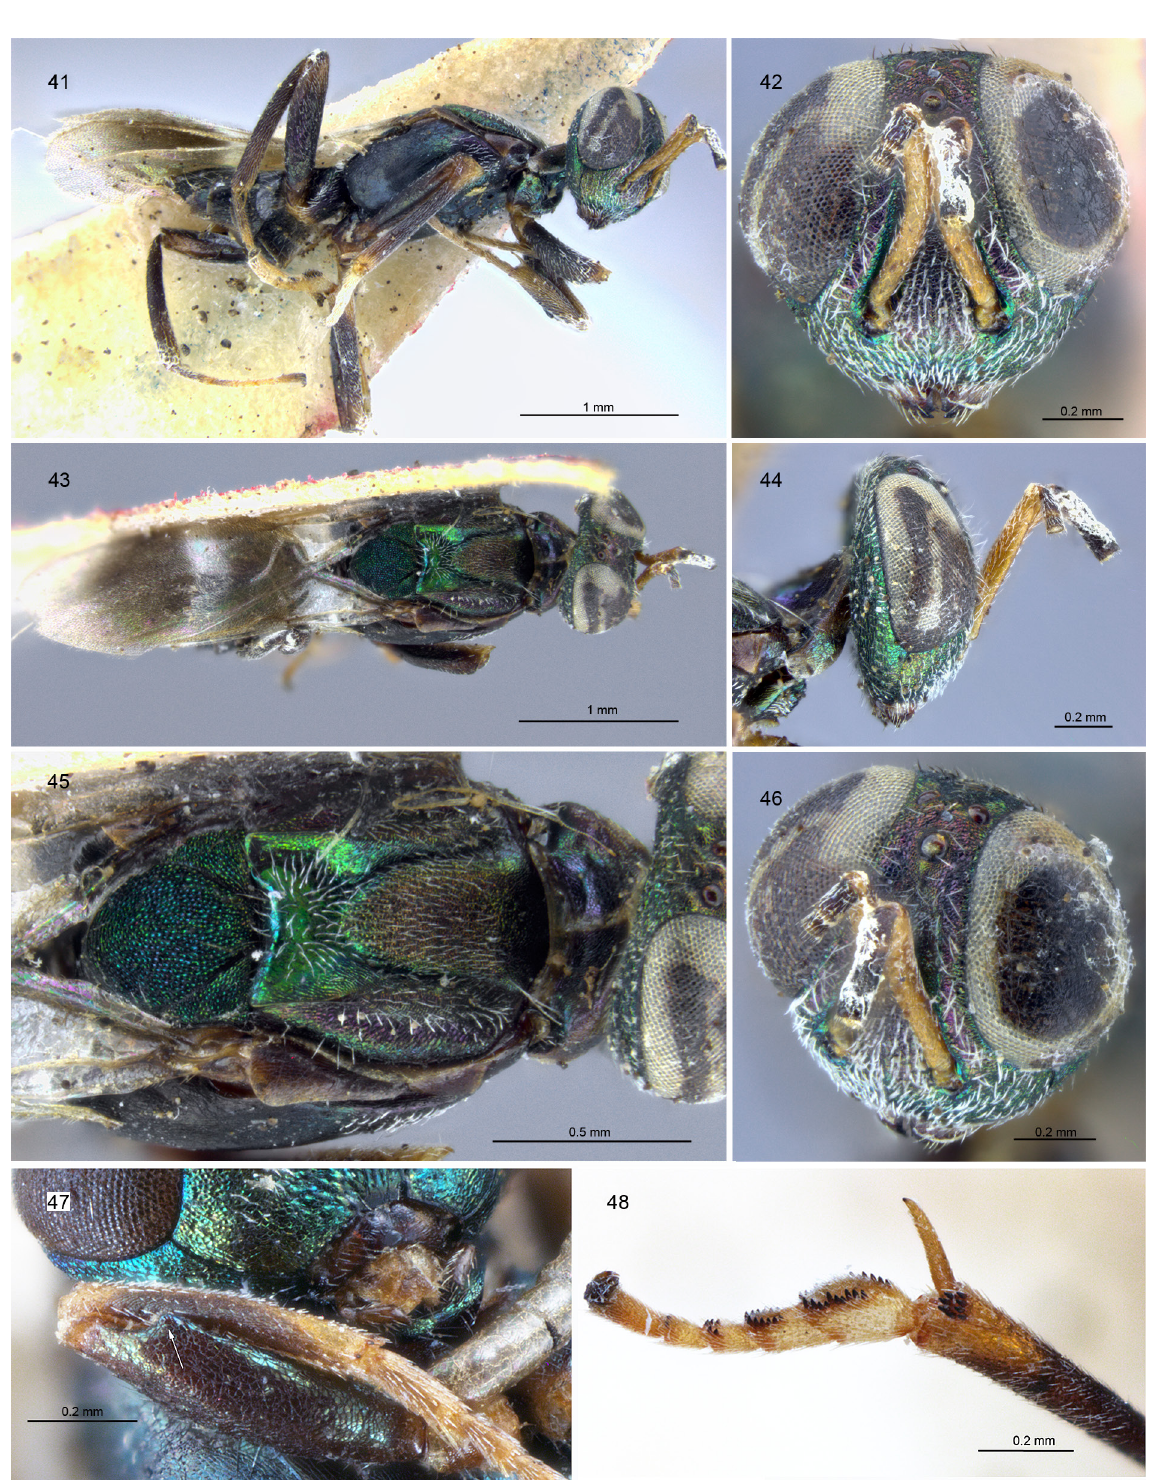
Figs 41–48. Anastatus shichengensis , ♀ . 41–46 . Holotype. 41 . Body, lateral view. 42 . Head, frontal view. 43 . Body, dorsal view. 44 . Head, lateral view. 45 . Mesosoma, dorsal view. 46 . Head, frontolateral view. – 47–48 . Paratype. 47 . Front leg (the tooth is arrowed). 48 . Apex of mesotibia and